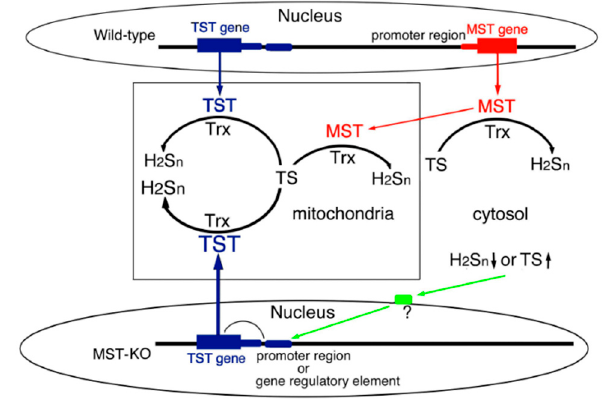
Figure 5. Proposed overexpression mechanism of TST. Decrease in cytosolic H 2 S n may directly or indirectly affect the promoter region or the cis-regulatory element between TST and MST structural genes. Then it may facilitate transcription of TST gene, resulting in overexpression of TST. Trx: thioredoxin; TS: thiosulfate; H 2 S n : polysulfides. ?: unspecified factors.